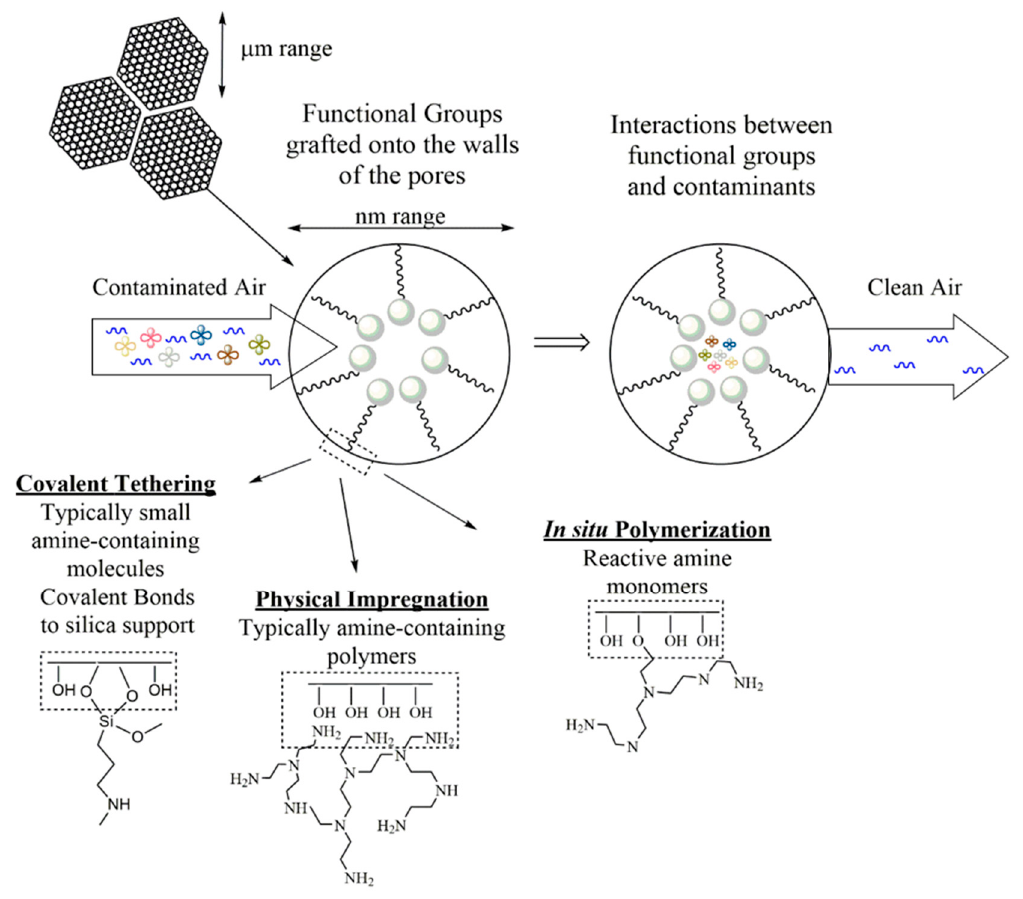
Figure 3. An example of mesoporous silica materials used for environmental remediation of